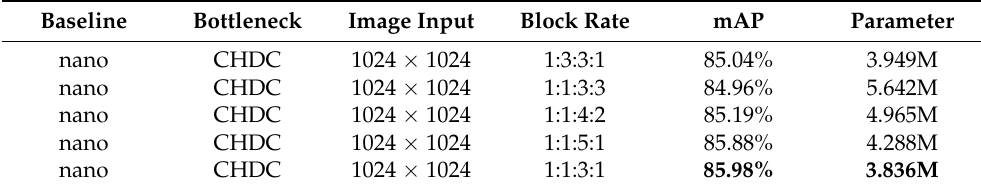
Table 7. Ablation experiments for stage compute rate in